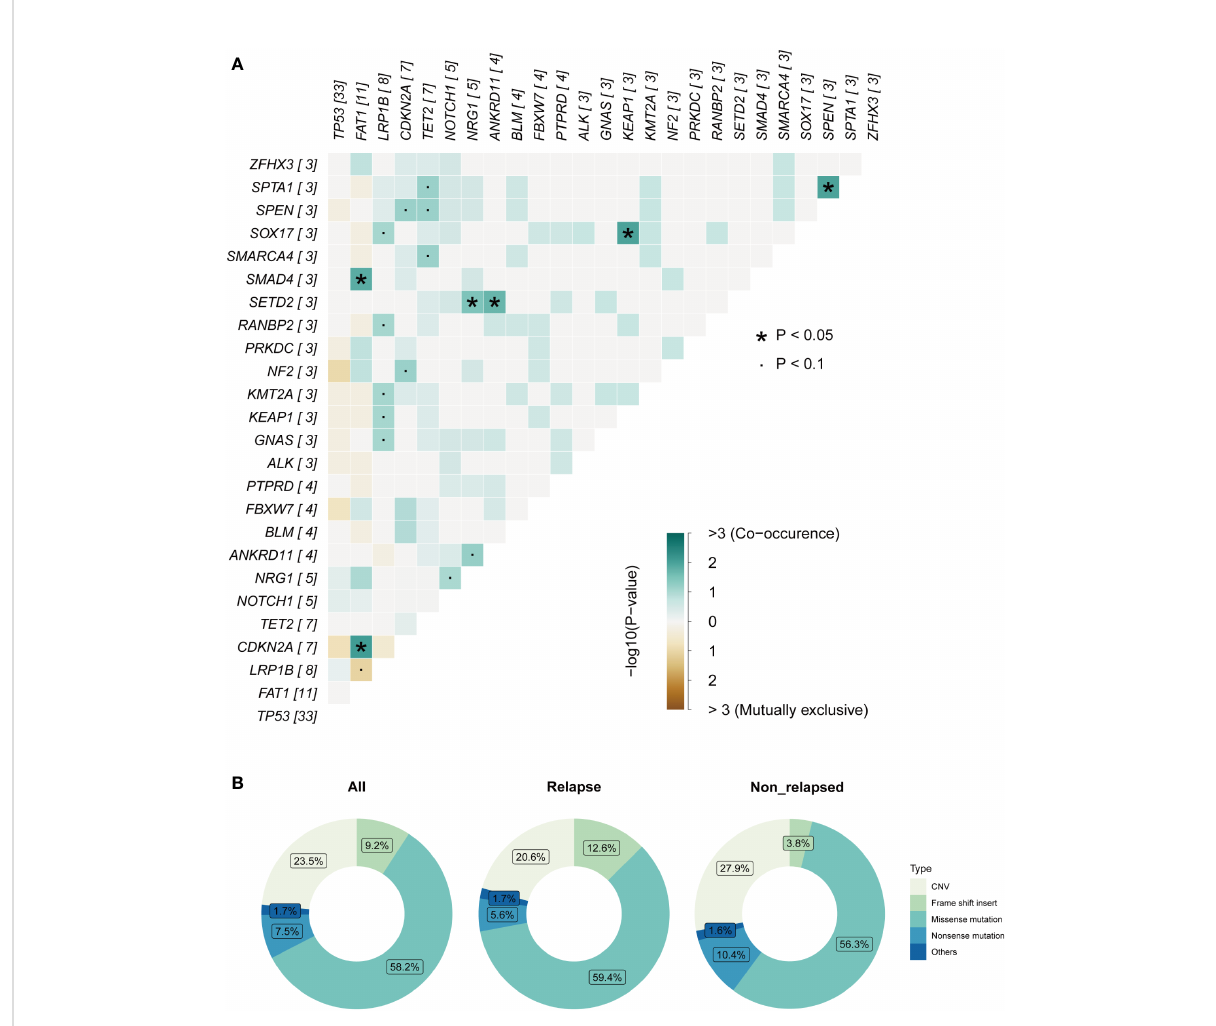
FIGURE 3 Mutation analysis of laryngeal cancer patients. (A) Pairwise mutual exclusivity and co-occurrence analysis in the cohort. (B) Separate group analyses showed no signi fi cant difference in the proportion of mutation types between the two de fi ned